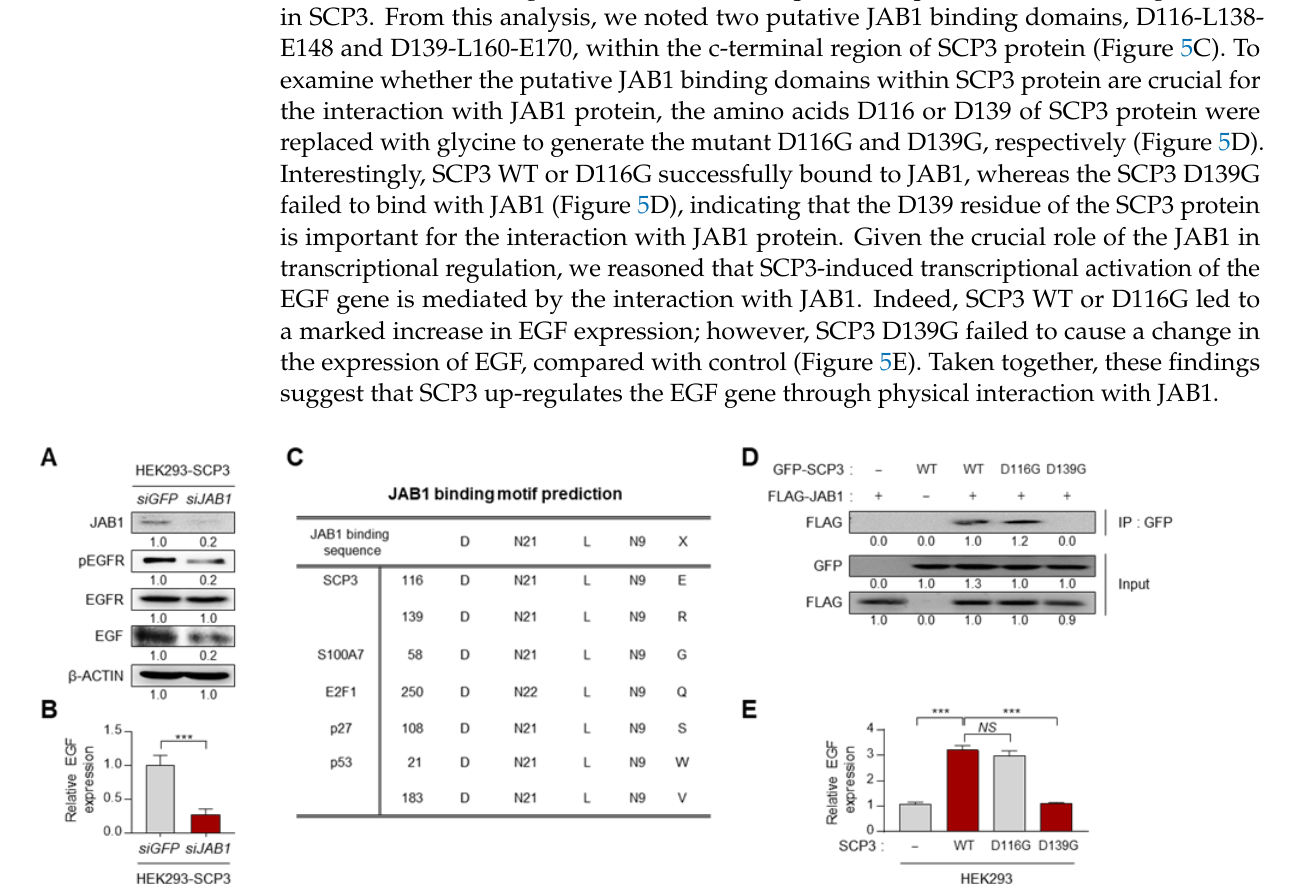
Figure 5. SCP3 transcriptionally up-regulates EGF through physical interaction with JAB1. ( A , B ) HEK293-SCP3 cells were treated with siGFP or siJAB1 . ( A ) Western blot analysis of JAB1, pEGFR, EGFR, and EGF expression. β-ACTIN was used as an internal loading control. ( B ) EGF mRNA expression was analyzed by qRT-PCR. ( C ) JAB1 binding motif prediction on SCP3, S100A7, E2F1, p27, and p53. ( D , E ) HEK293 cells were co-transfected with the indicated constructs. ( D ) Co-immunoprecipitation of SCP3 and JAB1. Lysates of the transfected cells immunoprecipitated with GFP antibody, followed by Western blotting using GFP and FLAG antibodies. ( E ) EGF mRNA expression was analyzed by qRT-PCR. All experiments were performed in triplicate. The p -values were determined by unpaired, two-tailed Student’s t -test. The data represent the mean ± SD (*** p ≤ 0.001. NS , not significant).